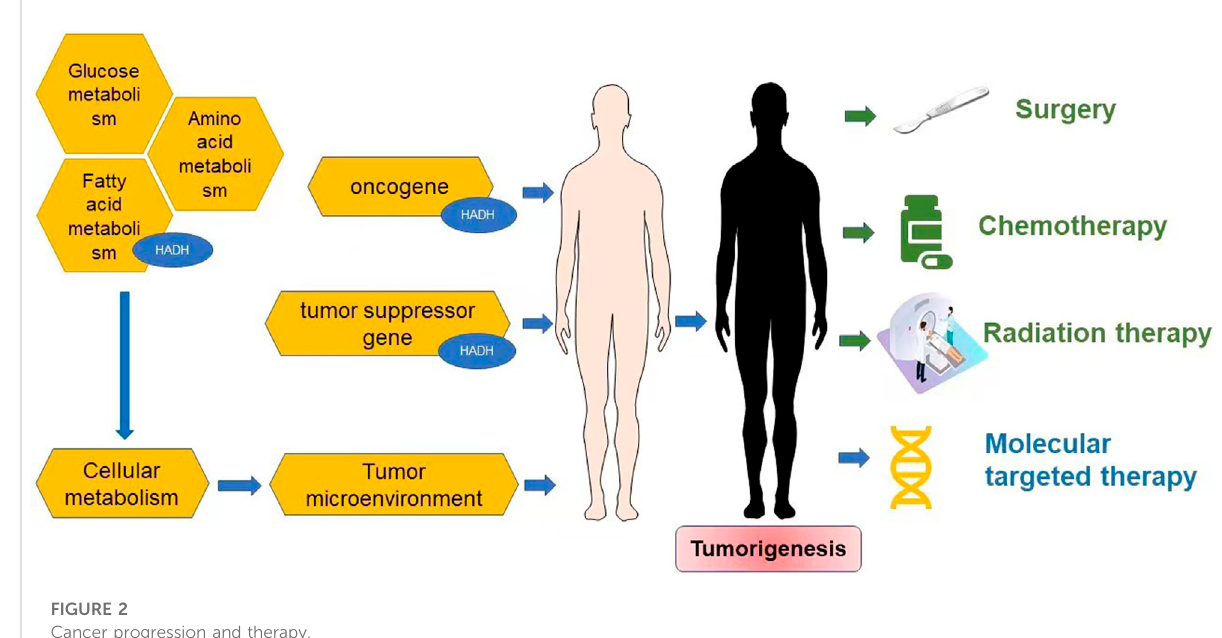
FIGURE 2 Cancer progression and therapy.